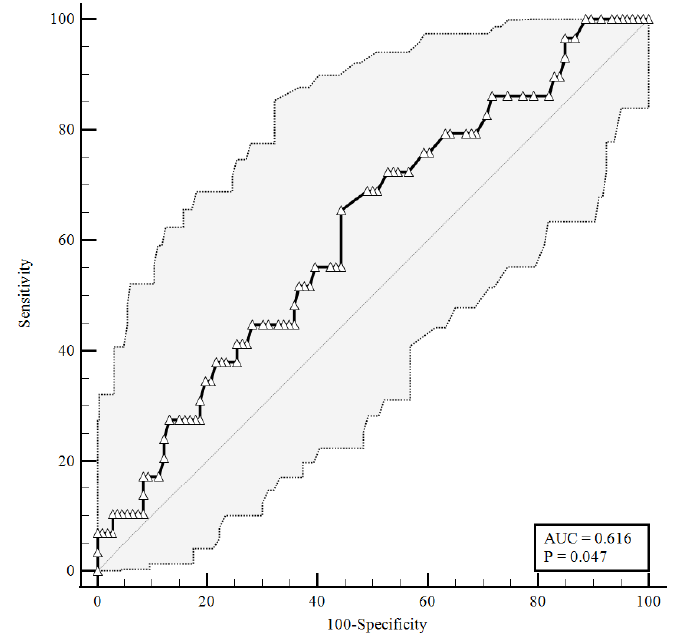
Figure 1. ROC curve for plasma CGRP levels at the time of hospital admission predicting a severe disease evolution (65.52% sensitivity, 55.66% specificity). AUC = area under the curve, p = p -value. As shown in Figure 2, a baseline plasma CGRP level lower than 1.26 ng/mL (AUC = 0.617) predicted a faster clinical recovery (85.06% sensitivity and 37.5% specificity), with a likelihood ratio of 1.36 (95% CI: 1.07 – 1.72).